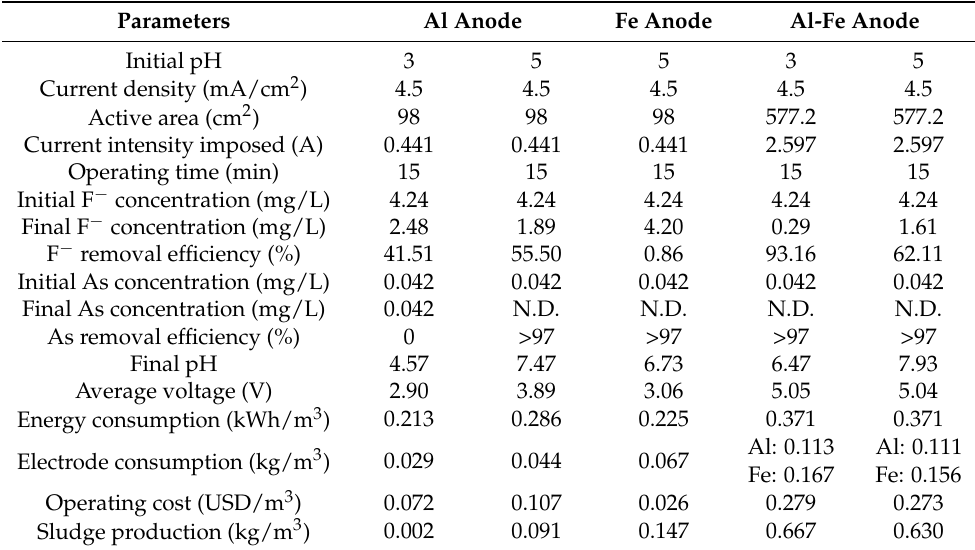
Table 2. Parameters and results of electrocoagulation tests for removal of arsenic and